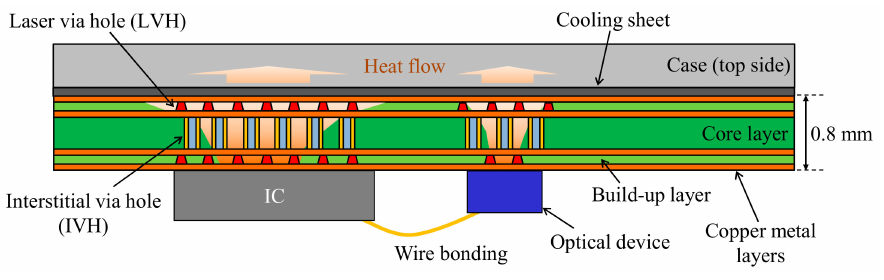
Figure 3. Structure of thermal vias in multi-layer